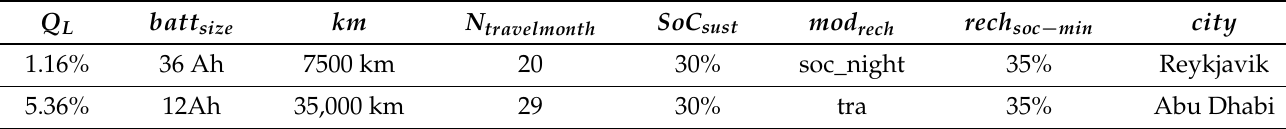
Table 6. Value of parameters for min and max capacity